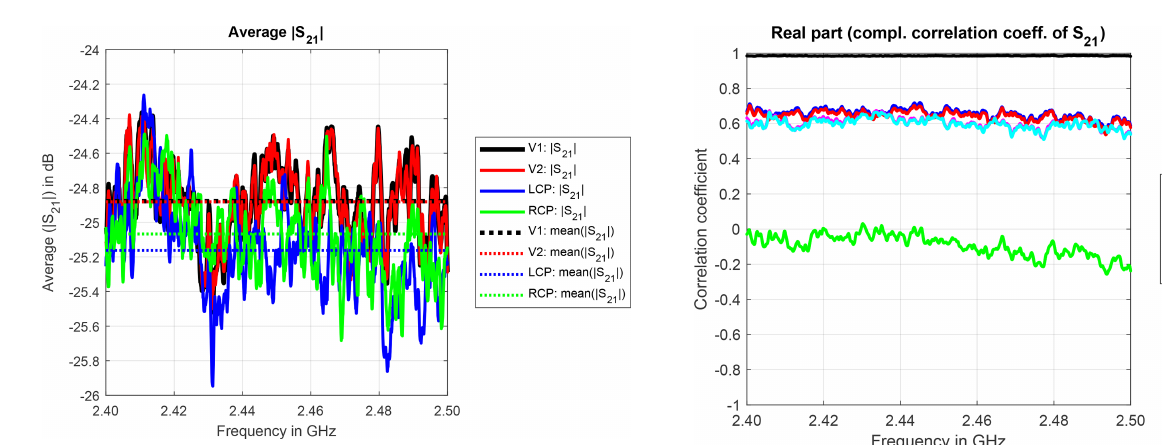
Figure 7. Real part of the complex correlation coefficients for dif- ferent antennas and measurement trial 4.